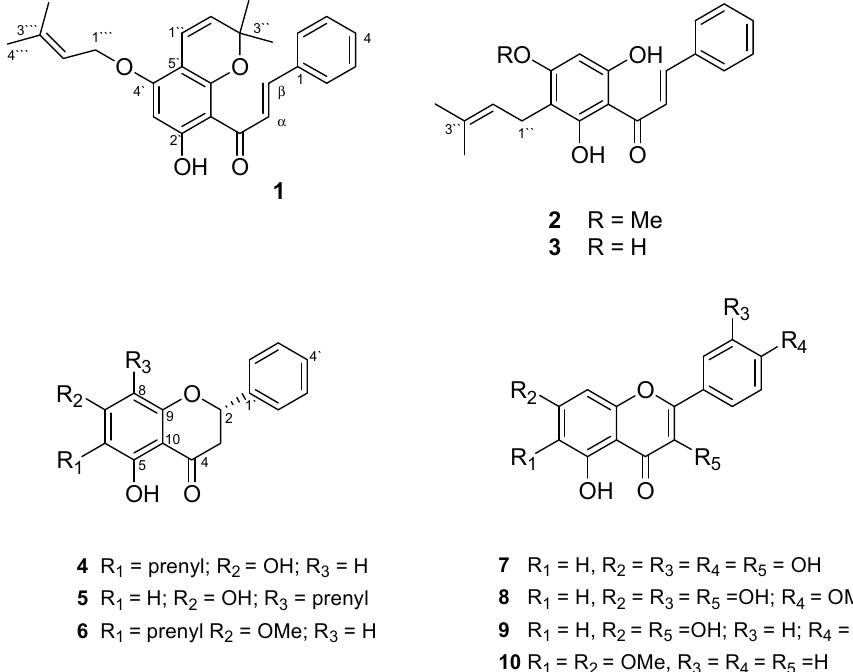
Figure 1. Chemical structures of compounds 1 – 10 isolated from H. teretifolium